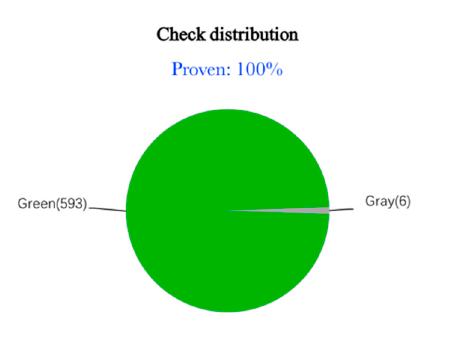
Figure 7. Result of PolySpace analysis.